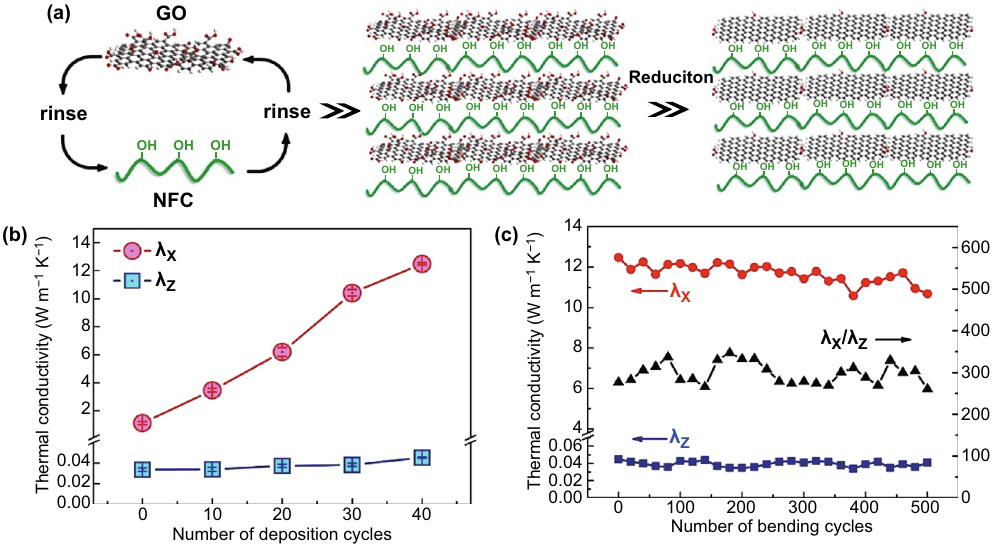
Fig. 17 a Schematic view of preparation and fabrication of (CNFs-rGO) n hybrid film by multilayer deposition assembly on a flexible CNF sub- strate. b Thermal conductivity of (CNFs-rGO) n hybrid film with ( n ) cyclical deposition on a flexible CNF substrate. c (CNFs-rGO) n hybrid film in-planer ( λ X ) and cross-plane ( λ Z ) under bending cycles. Reproduced with permission from Ref. [96] Copyright © 2017, American Chemical